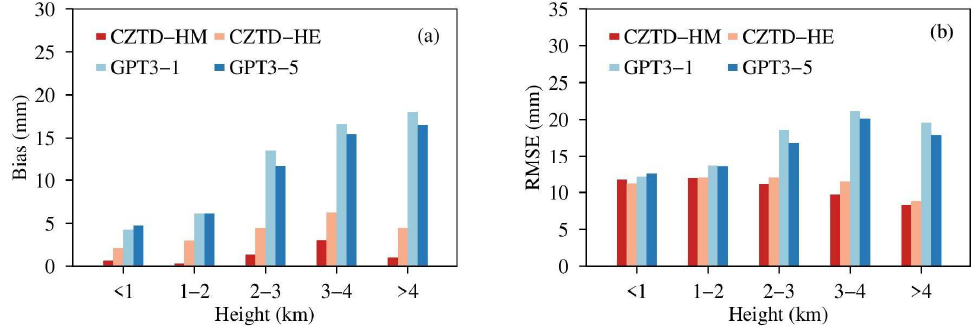
Figure 7. Bias and RMSE of spatial interpolation for GGOS gridded ZTD for CZTD-H and GPT3 models at different heights validated by GNSS data.